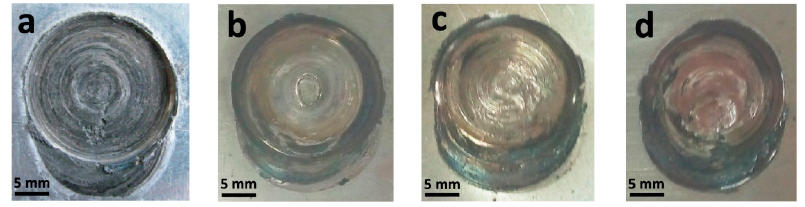
Figure 4. Solder joint appearance of FSKSW: ( a ) AZ31/DP600; ( b ) AZ31/non-zinc-coated DP600; ( c ) Mg/DP600; ( d ) Mg/non-zinc-coated DP600.